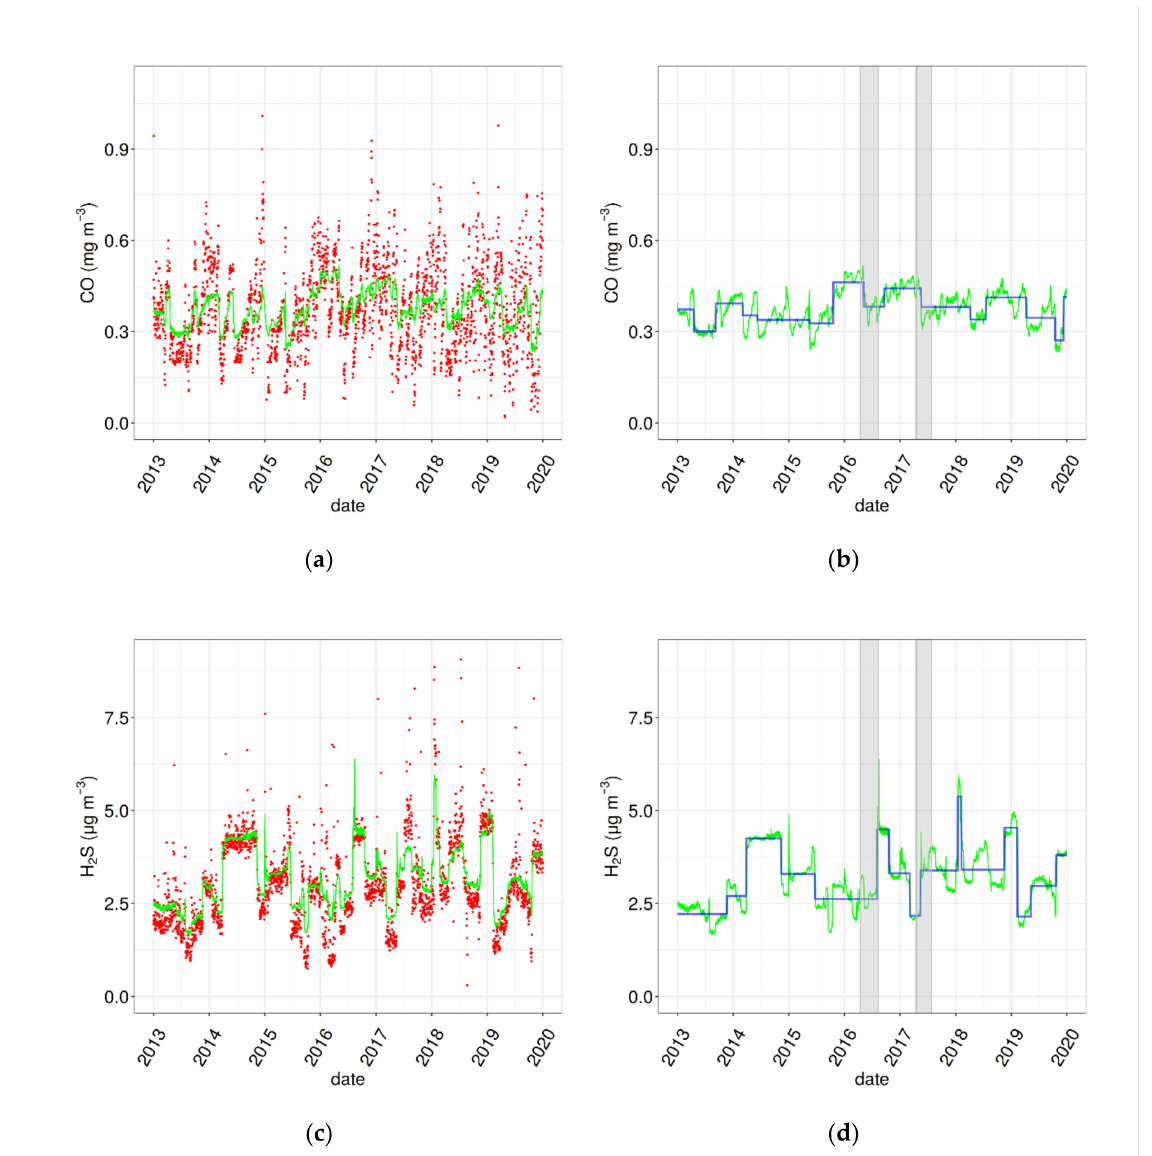
Figure 6. ( a , c ) daily averages of observed (red dots) and meteorologically normalized (green lines) CO and H2S concentrations. ( b , d ) the wbs change points (blue lines) and the periods of COVA plant shutdowns (grey